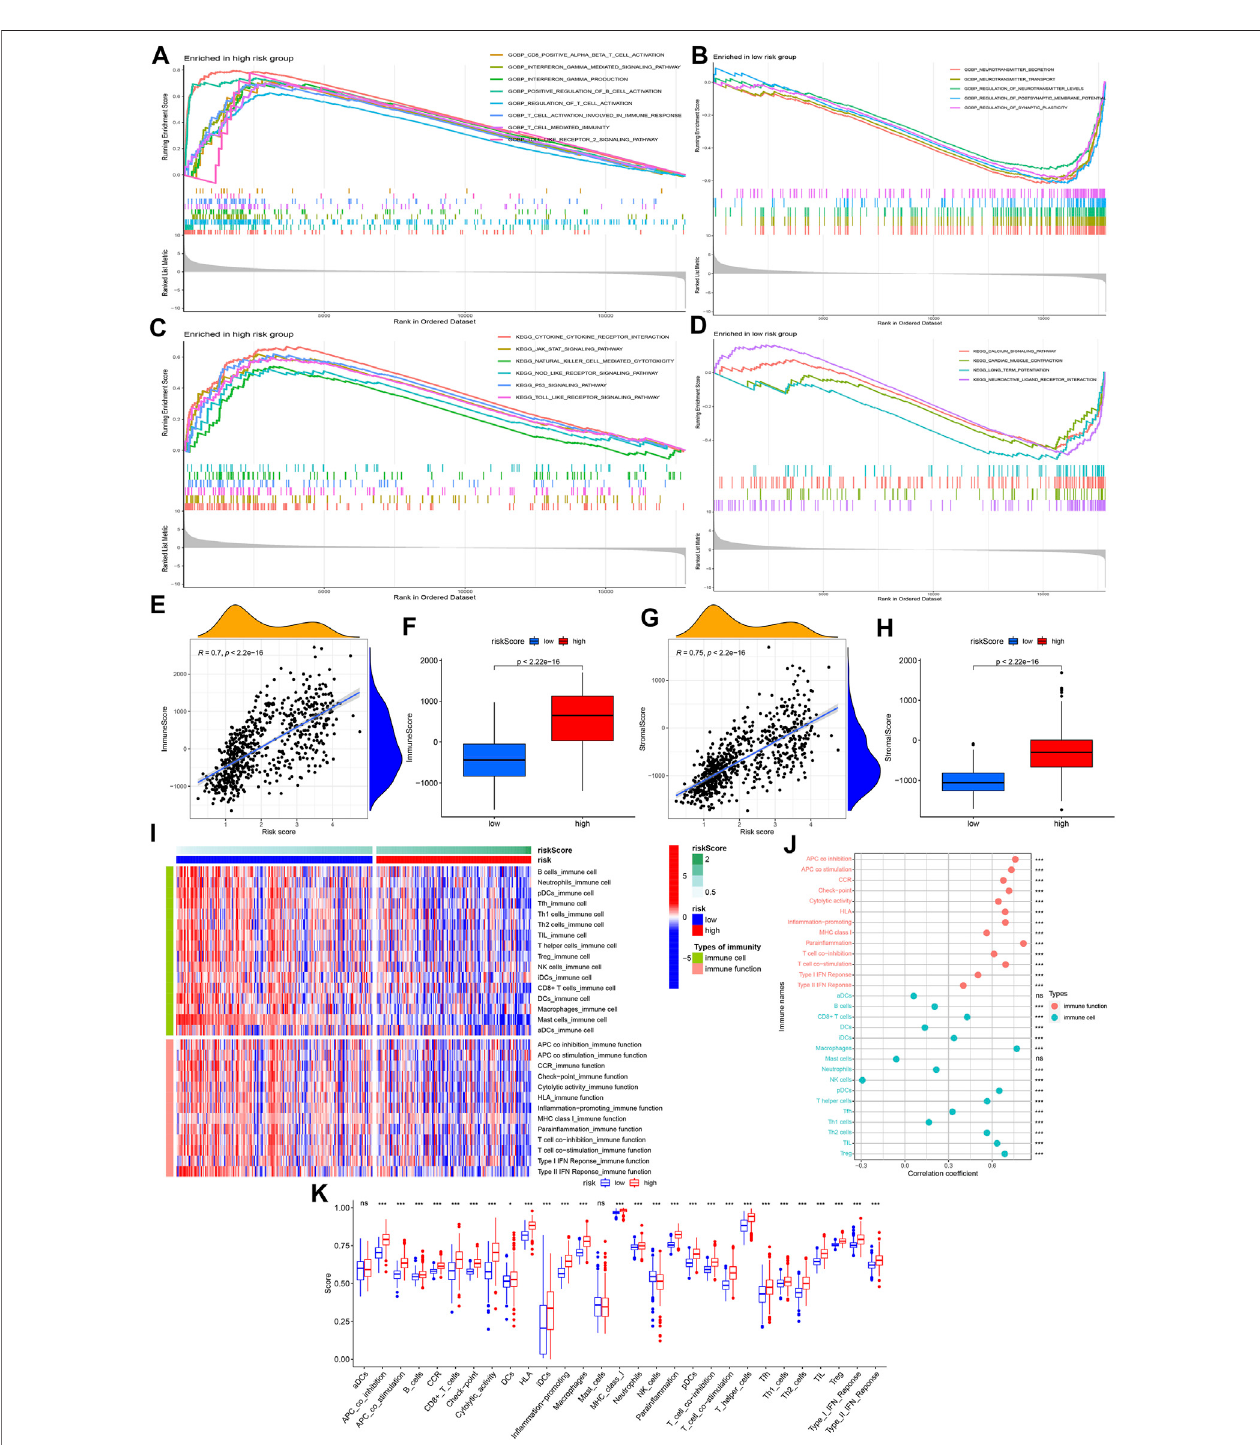
FIGURE 7 | GSEA and tumor immunosuppressive environment analysis. (A , B) GO enrichment analysis results of high-risk group and low-risk group. (C , D) KEGG enrichment analysis results of high-risk group and low-risk group. (E , G) Correlation analysis results between risk score and overall immune score/stromal score. (F , H) Difference analysis results of overall immune score/stromal score between the high-risk and low-risk groups. (I) Heatmap visualizing 16 immune cell and 13 immune functionscoresforeach sample. (J) Correlation analysisresults betweenriskscoreand 16immune cells/13 immunefunctions. (K) Difference analysisresultsof16 immune cells/13 immune functions between the high-risk and low-risk groups. The symbols on the right and top of the graph represent different p values, respectively. ns: no signi fi cance; * p < 0.05; ** p < 0.01; *** p < 0.001.